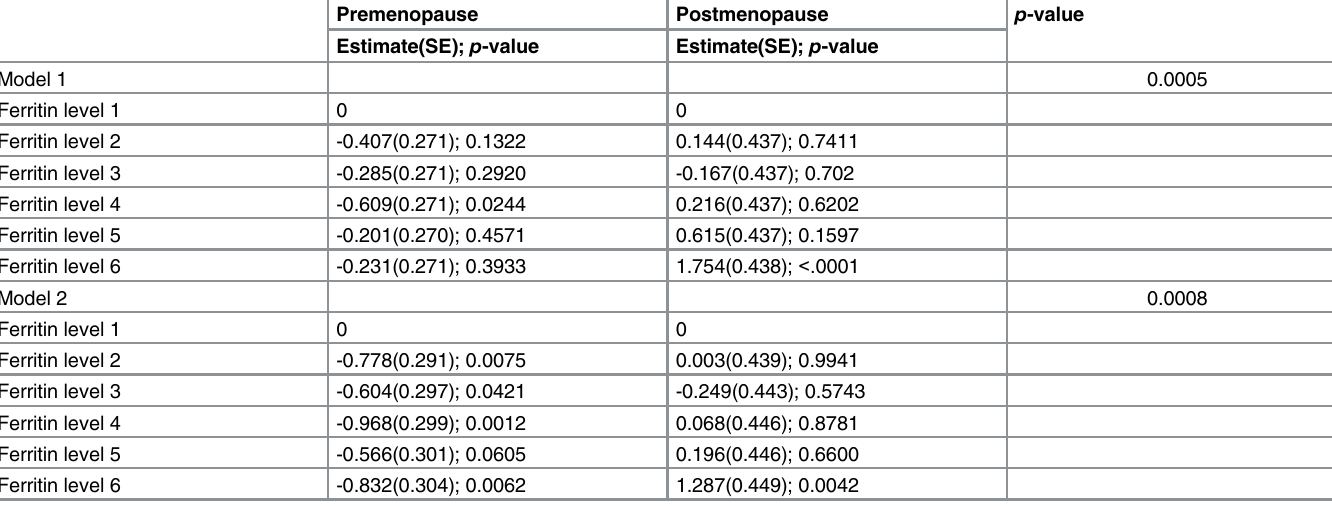
Table 6. Estimated regression coefficient for insulin by serum ferritin groups.